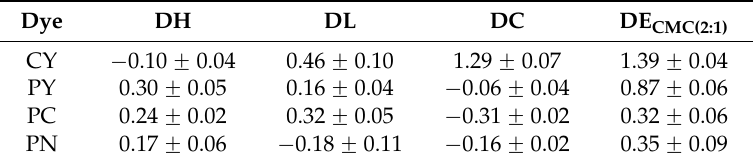
Table 5. Colour differences values for decoloured concentrate effluent